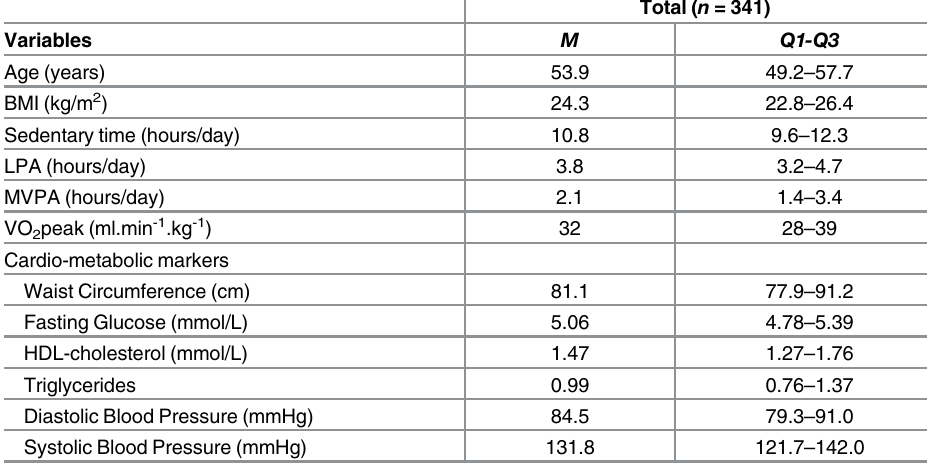
Table 1. Descriptive statistics for age, physical activity, physical fitness and cardio-metabolic